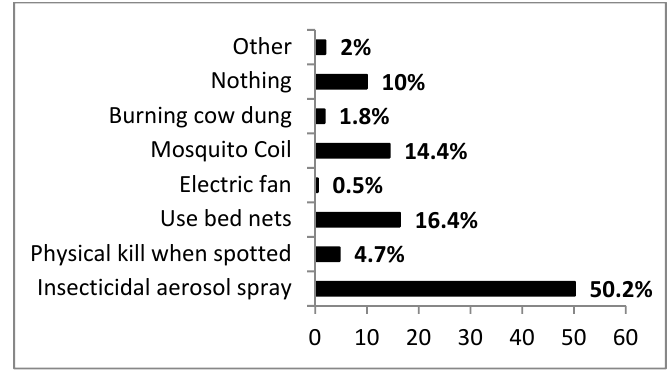
Figure 5. Summary responses (%) on how respondents protect themselves from indoor mosquito bites across sub-districts.